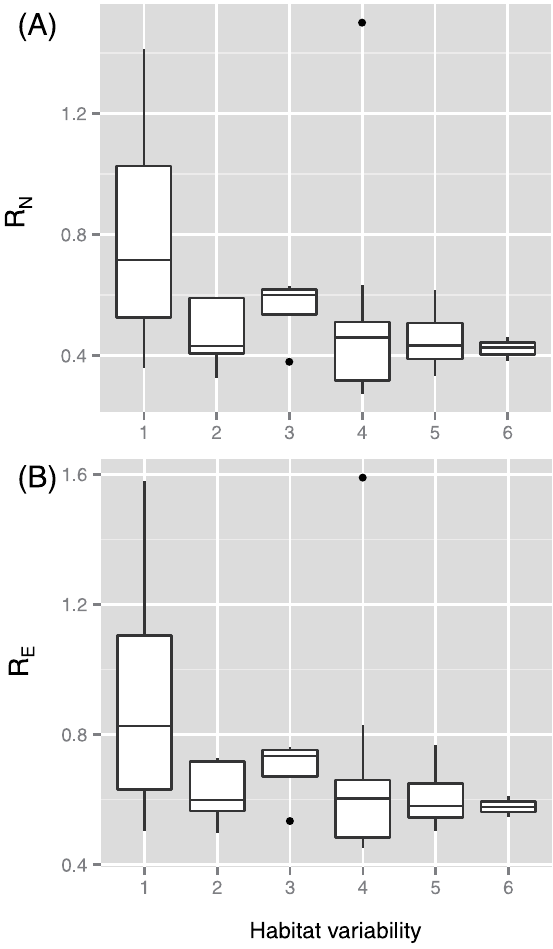
Figure 3. Change ratio of network parameters between the latest version and earlier version of metabolic networks. (A) In the case of the number of nodes ( p =1.5 6 10 2 6 using the Kruskal-Wallis (KW) test). (B) In the case of the number of edges ( p =8.8 6 10 2 6 using the KW test).